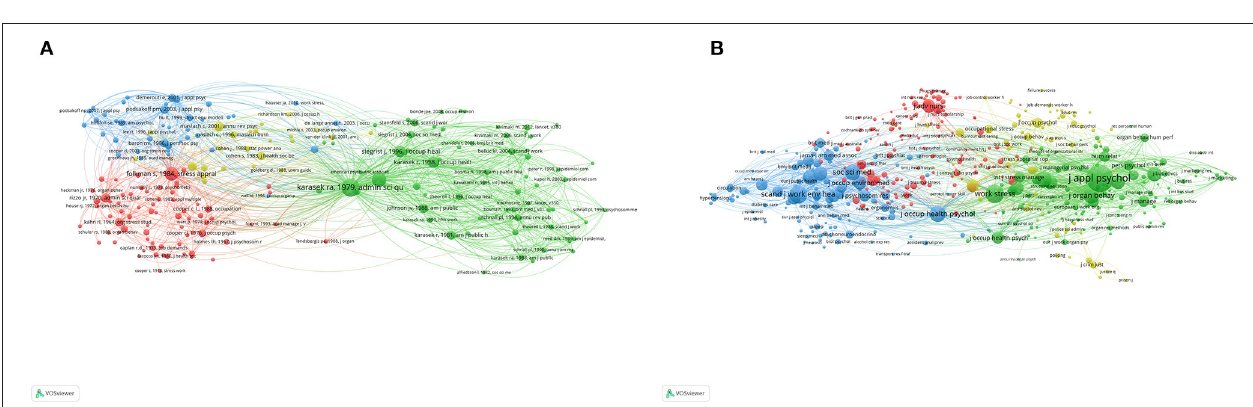
FIGURE 4 | Bibliometric analysis of co-authorship. (A) Co-authorship map of organizations. (B) Co-authorship map of countries. Different colors indicate different clusters, and the size of circles indicate the number of publications. The thickness of the lines represents the link strength of the organizations or countries.